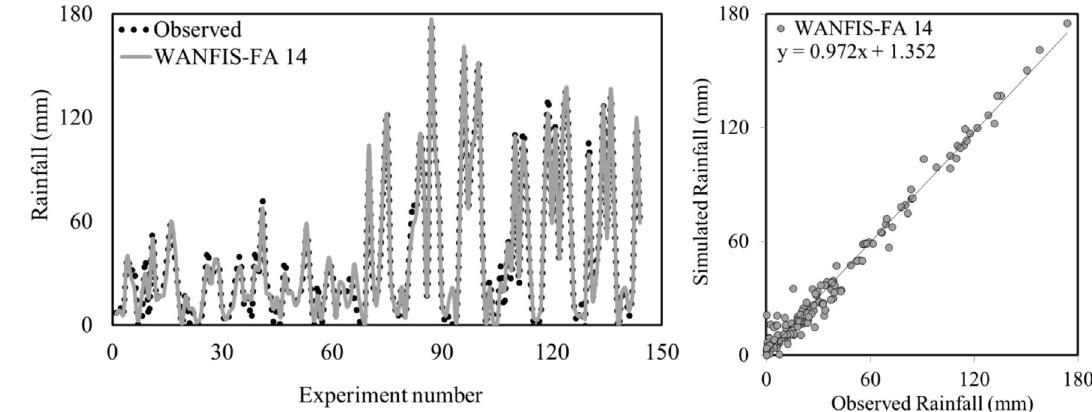
Fig. 12 Scatter plot and comparison of numerical and observed values of superior model (WANFIS-FA14)